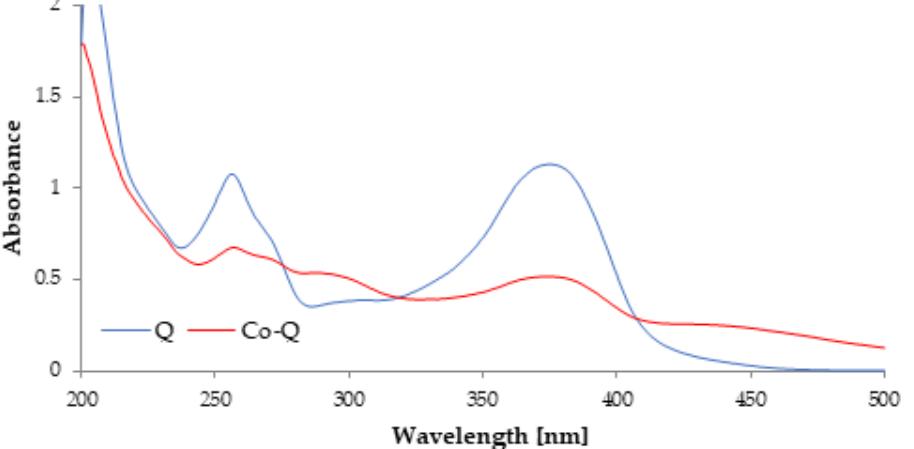
Figure 3. UV spectra for quercetin (Q) and cobalt(II) complex of quercetin(Co-Q) at the concentration C = 5 · 10 − 5 M registered in Tris-HCl for (pH = 7.4).